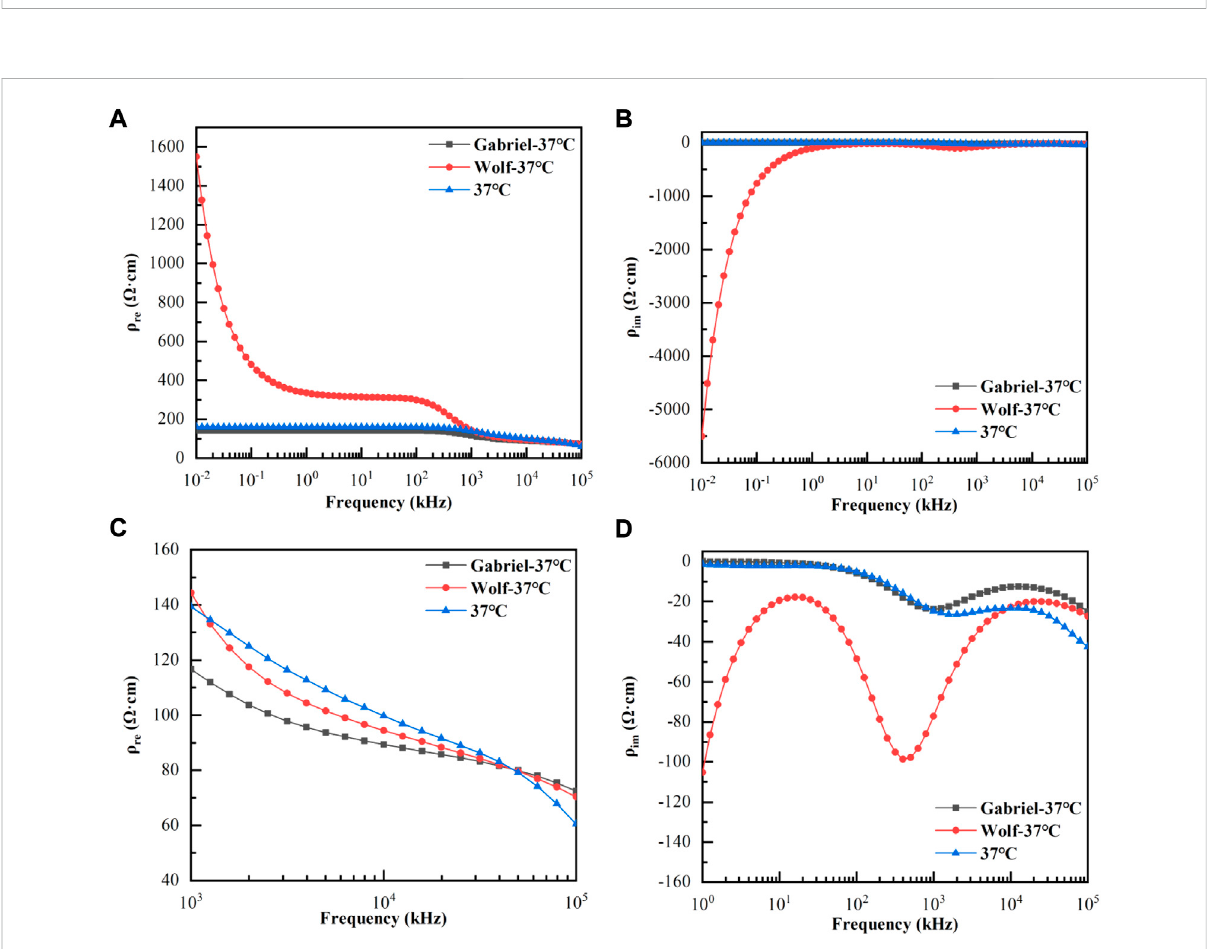
FIGURE 3 Variationoftherealandimaginarypartsofthebloodresistivitieswithfrequenciesat37 ° C. (A) :Realpartsofresistivitiesat10Hz – 100 MHz; (B) :Imaginary parts of resistivities at 10 Hz – 100 MHz; (C) : Real parts of resistivities at 1 kHz – 100 MHz; (D) : Imaginary parts of resistivities at 1 kHz – 100